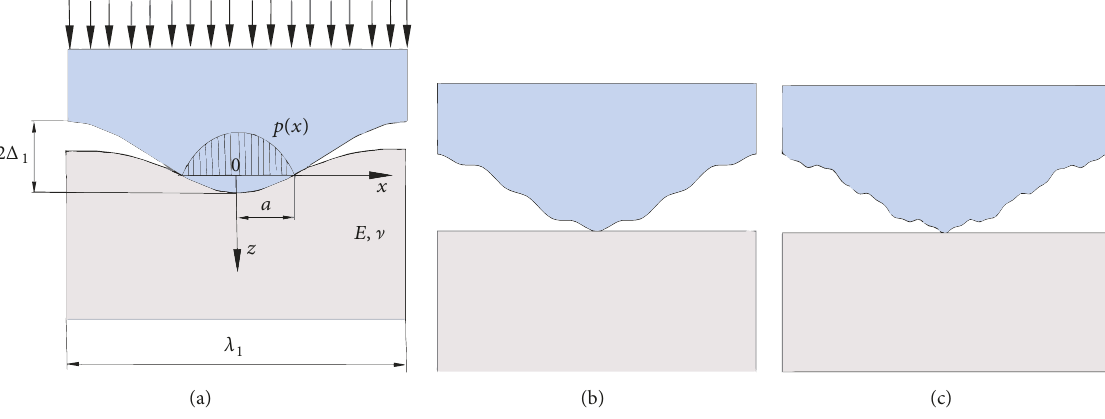
Figure 1: Contact of a cosine wavy profile, having one (a), two (b), and three (c) harmonics with an elastic half-plane.